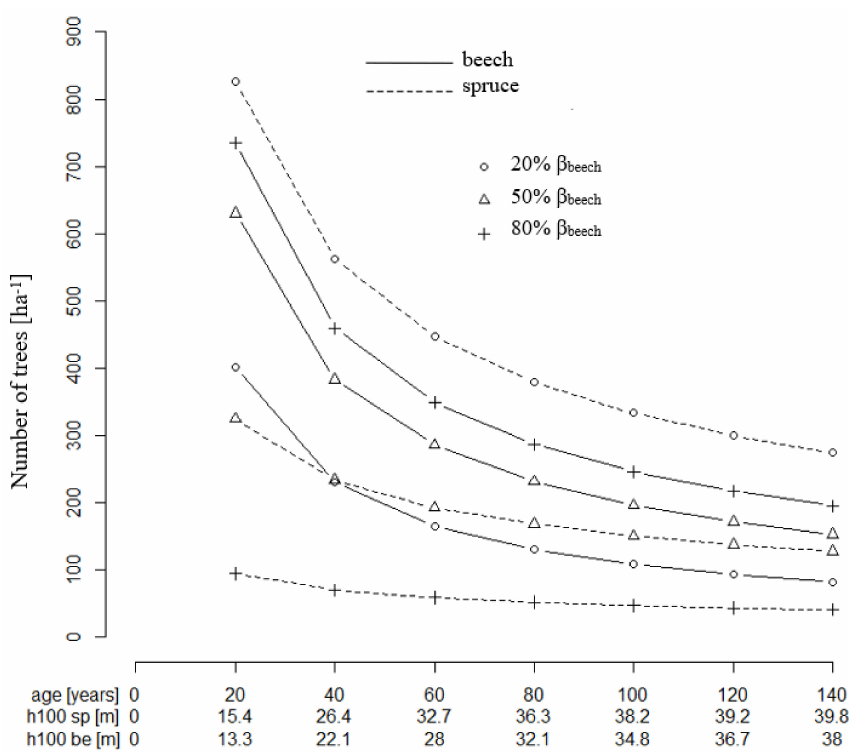
Figure 6. Guide curves of tree number per ha over age calculated with Equation (13) for Norway spruce ( sp ) and European beech ( be ) and each of three different basal area shares ( β species = 20%, 50% and 80%); The diameter at breast height was taken according to the stand age (Figure 2); parameters c 1 and c 2 in Equation (13) were taken from Table